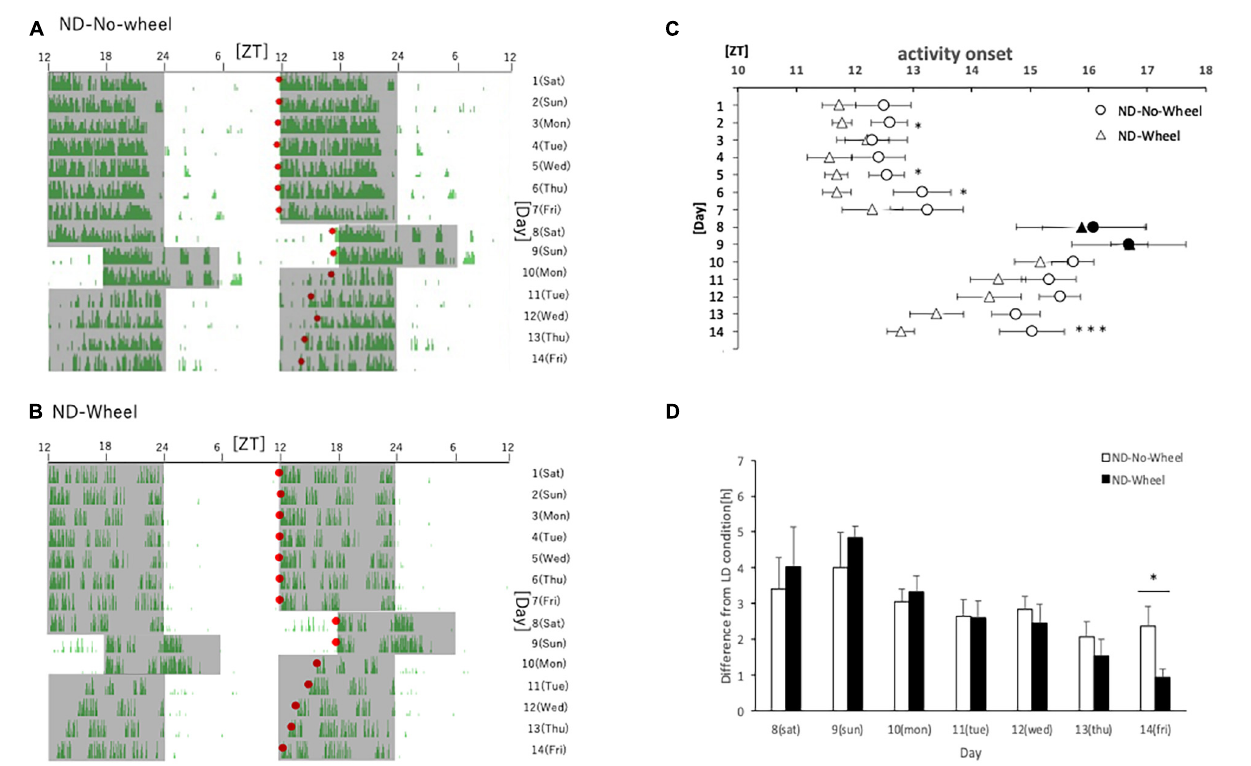
FIGURE 1 | Behavioral rhythms in the SJL condition during ND feeding. (A) Typical double-plot actogram of behavior measured by infrared sensor during one week of rearing under the normal LD condition (days 1–7) and one week of rearing under the SJL condition (days 8–14). On days 8 and 9, which are Saturdays and Sundays, the LD conditions were set back by 6 h. (B) Double-plot actogram of behavioral rhythms measured with a wheel-running device on a similar schedule. (C) Activity onset time was calculated from the daily activity rhythms and averaged per group. Saturdays and Sundays with different start of the dark period are indicated by black marks. Data are presented as mean ± standard error of the mean (ND-No-Wheel, n = 5; ND-Wheel, n = 9). (D) Difference between mean activity onset time during the first half of the week (day 1–7) and activity onset time during the SJL condition (day 8–14). * p < 0.05, *** p < 0.001 ( t